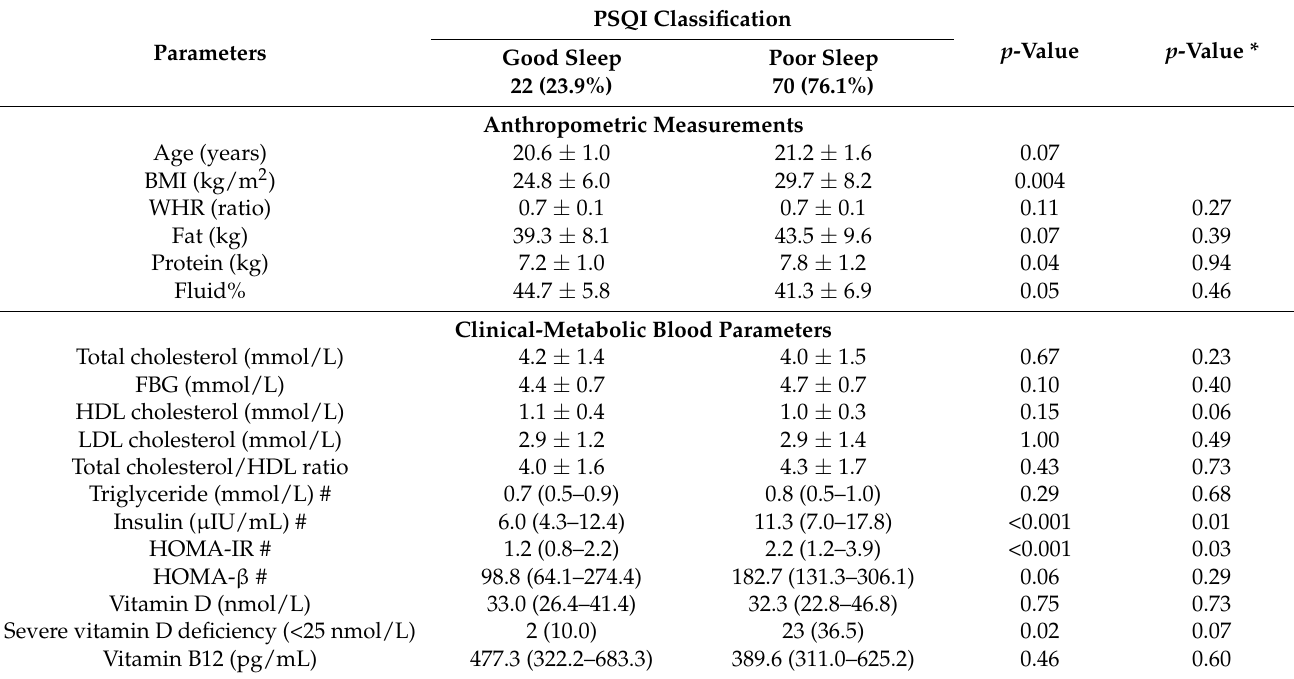
Table 1. Anthropometric and clinical-metabolic blood parameters according to PSQI sleep